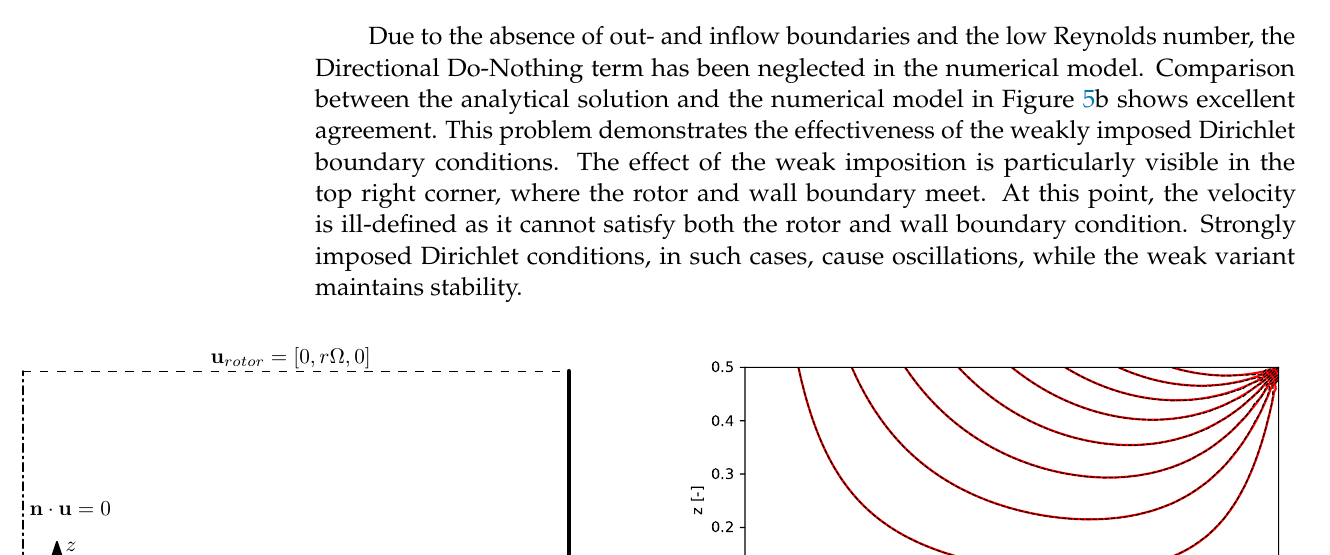
Table 1. Parameters used for the enclosed rotating disk test-case.